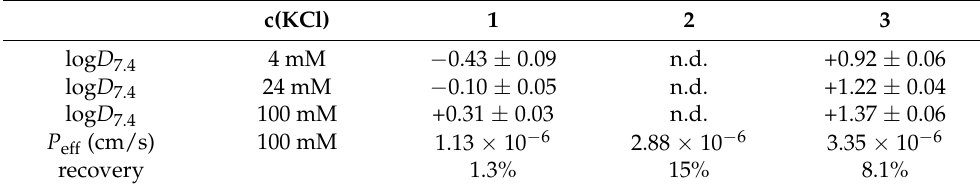
Table 4. Log D 7.4 ( n -octanol/water) and effective passive permeability values ( P eff ) of complexes 1–3 at pH = 7.4. { T = 25.0 ◦ C, 20 mM phosphate